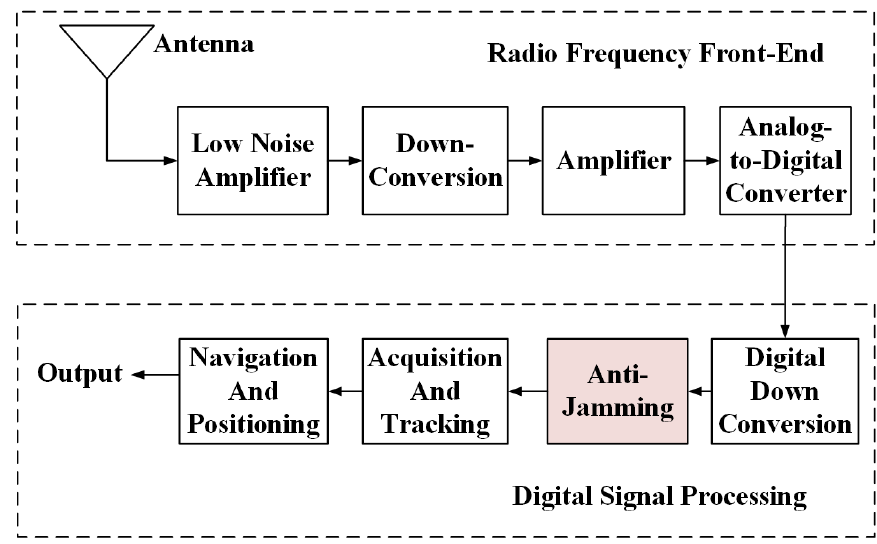
Figure 3. Navigation receiver structure.